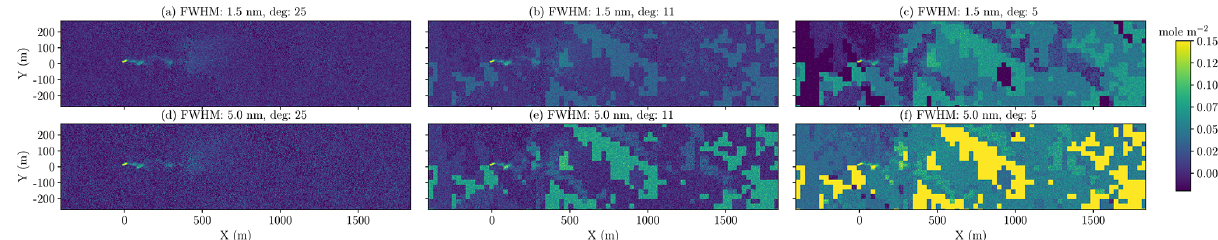
Figure 16. Retrieved CH 4 column over a well pad in the Durango, Colorado, area with varying instrument FWHM and polynomial degrees in the retrieval. The realistic surface distribution is based on LANDSAT data. The use of a polynomial degree of 25 and a FWHM of 1.5nm can reduce biases and precision error over this